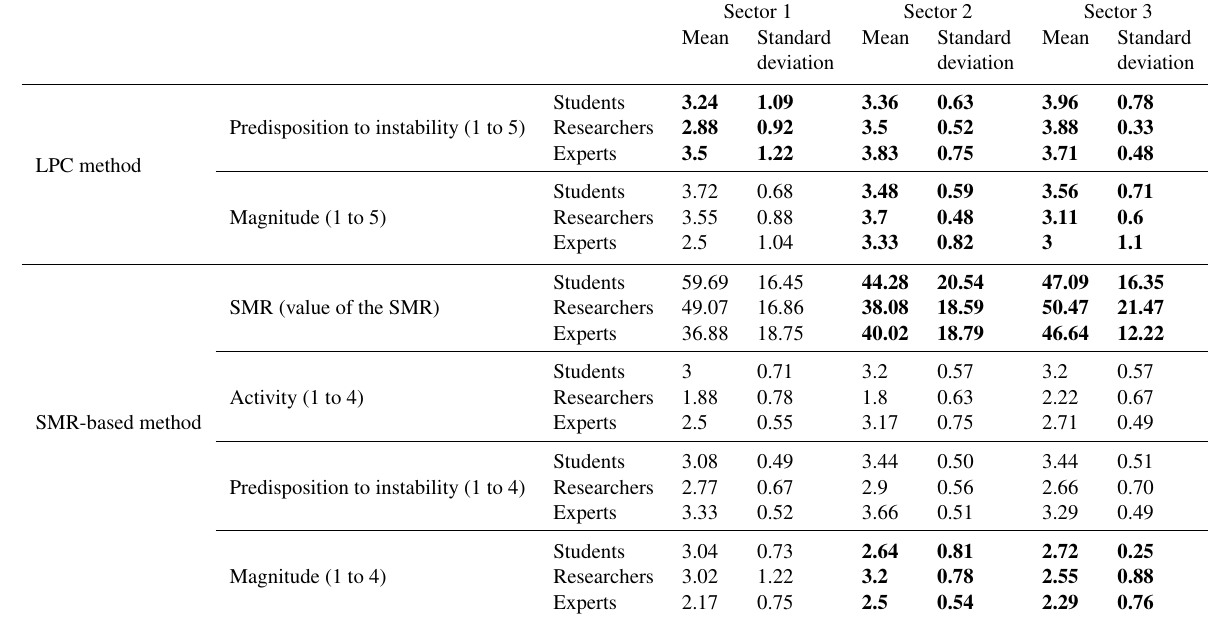
Table 16. Sample mean and standard deviation of the values of the LPC and SMR-based parameters. The bold values correspond to the population means that cannot be significantly